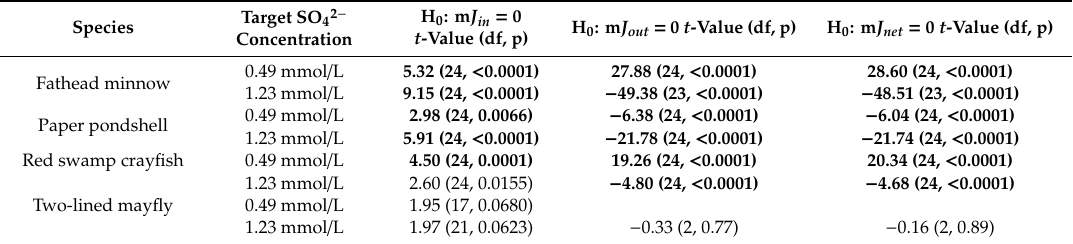
Table 4. T-value (df and p) for the test of the H 0 that each mean J = 0. m J in , m J out , and m J net are the mean influx rate, mean e ffl ux rate, and mean net flux of SO 42 − , respectively, for each species. Because of the multiple tests for each animal species, the Bonferroni adjustment of p is 0.0083. The t -values that indicate a mean J value statistically di ff erent from 0 are in